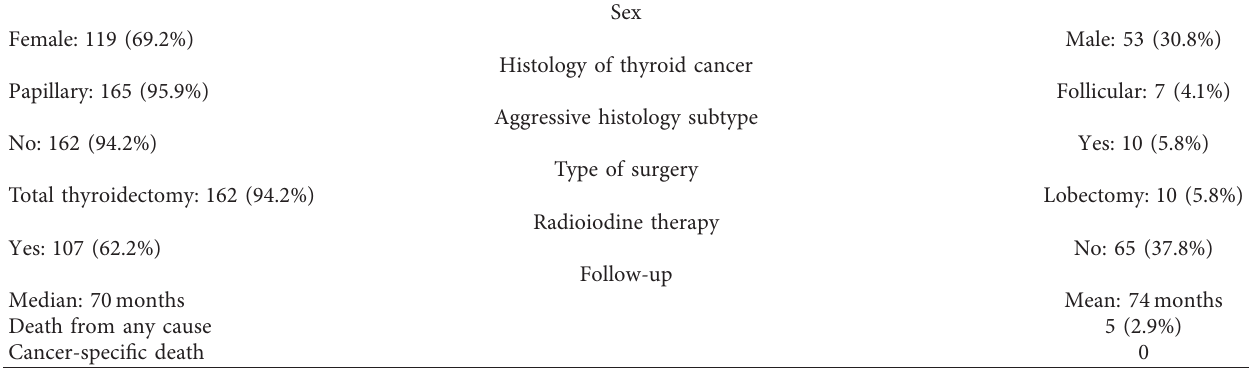
Table 2: Demographic, clinical, and histology characteristics of the 172 patients operated for differentiated thyroid carcinoma (DTC) diagnosed at the age of 45–54